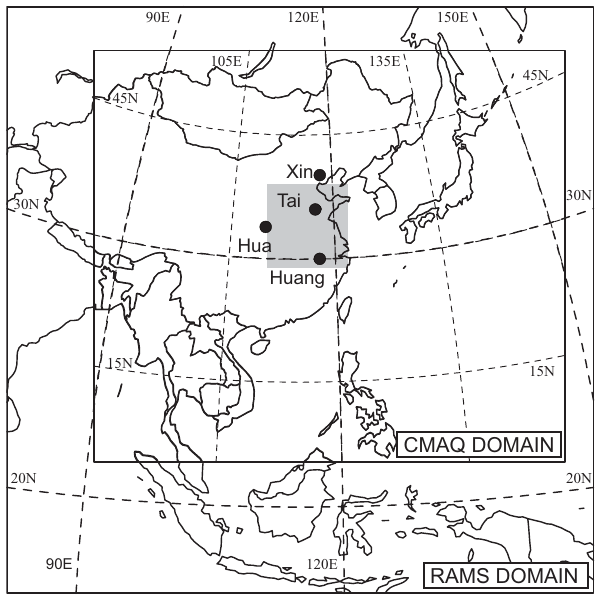
Fig. 1. Model domains for CMAQ (inside) and RAMS (outside) simulations. Tai (Mount Tai) (36 ◦ N, 117 ◦ E, 1533m a.s.l.), Hua (Mount Hua) (34 ◦ N, 110 ◦ E, 2064m a.s.l.), Huang (Mount Huang) (30 ◦ N, 118 ◦ E, 1836m a.s.l.), and Xin (Xinglong) (40 ◦ N, 118 ◦ E, 960m a.s.l.) are shown. The domain with a dark gray shadow is defined as Central Eastern China